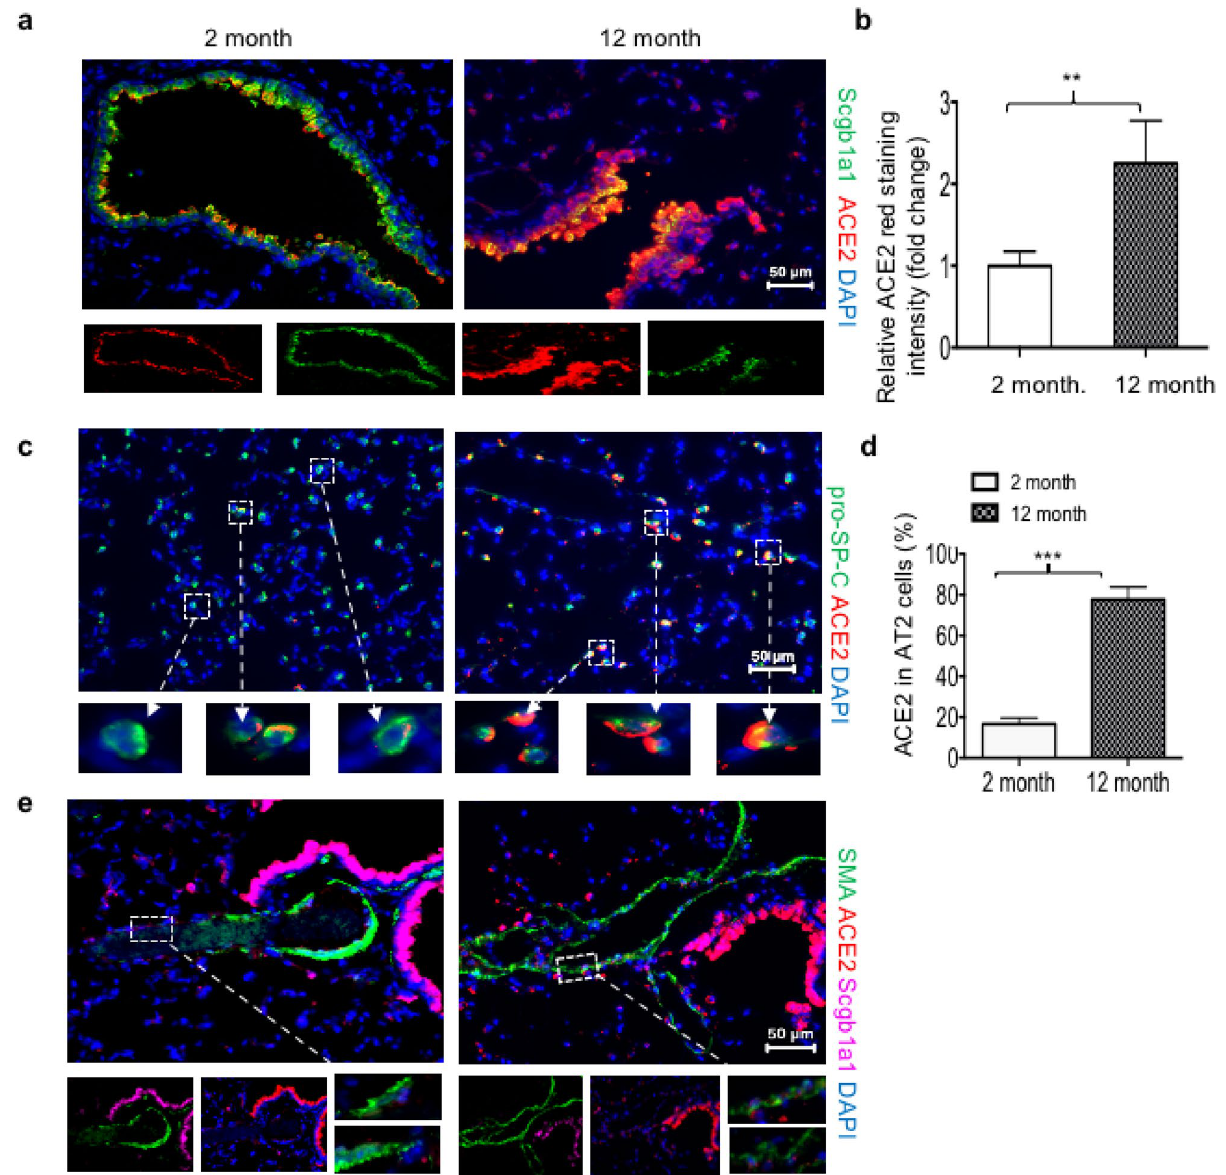
Figure 2. Aging increases ACE2 expression in airway Club and alveolar type 2 cells. ( a ) Lungs from 2-month and 12-month-old mice were immunostained for ACE2 (red), Scgb1a1 (green), and counterstained with DAPI (blue). Boxed sections are individual ACE2 and Scgb1a1 stains. ( b ) Quantification of airway of ACE2 staining was determined from 5 random airway images of 5 mice per group using identical exposure time. Scale bar = 50 μm. ( c ) Lungs were stained for ACE2 (red), proSP-C (green), and counterstained with DAPI (blue). Boxed sections are enlarged below each figure. ( d ) The proportion of proSP-C + cells expressing ACE2 was quantified from 5 random images taken from 5 mice per group and graphed. Statistical significance is comparisons for all pairs using Tukey–Kramer HSD test, with **P ≤ 0.01; ***P ≤ 0.001. Bar = 50